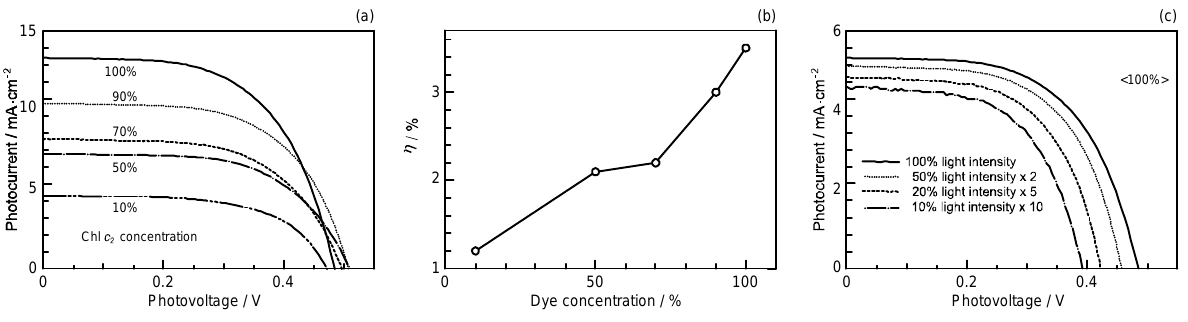
Figure 42. Concentration dependence of the conversion efficiency ( η ), and (c) the light- intensity dependence of the I–V (a) the I–V curves, (b) curves in the Chl c cell (reprinted from [21], Copyright (2007), with permission from